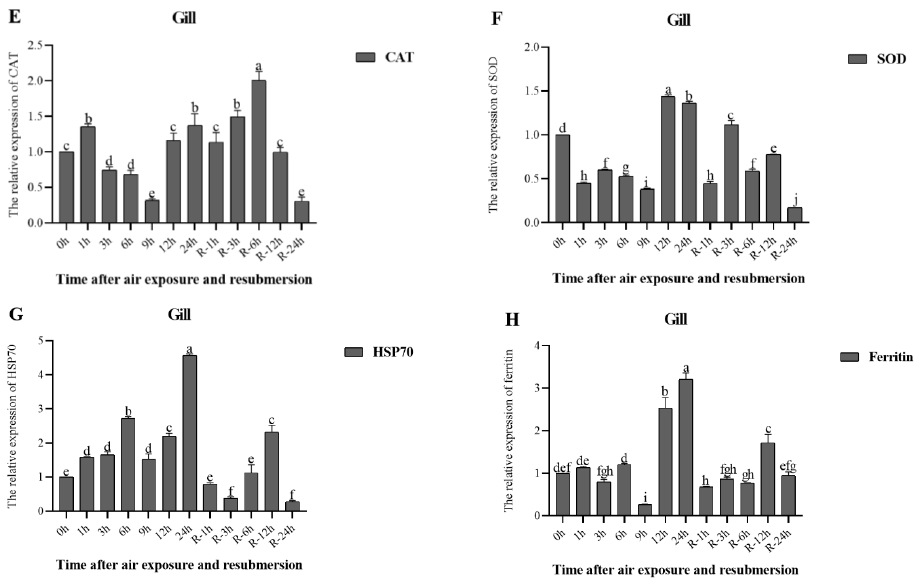
Figure 6. Relative expression levels of CAT ( E ), SOD ( F ), HSP70 ( G ), and Ferritin ( H ) in the gills of P. clarkii after air exposure for 0 h, 1 h, 3 h, 6 h, 9 h, 12 h, and 24 h, including re-submersion for R-1 h, R-3 h, R-6 h, R-12 h, and R-24 h. Different letters represent significant differences between various exposure times ( p <